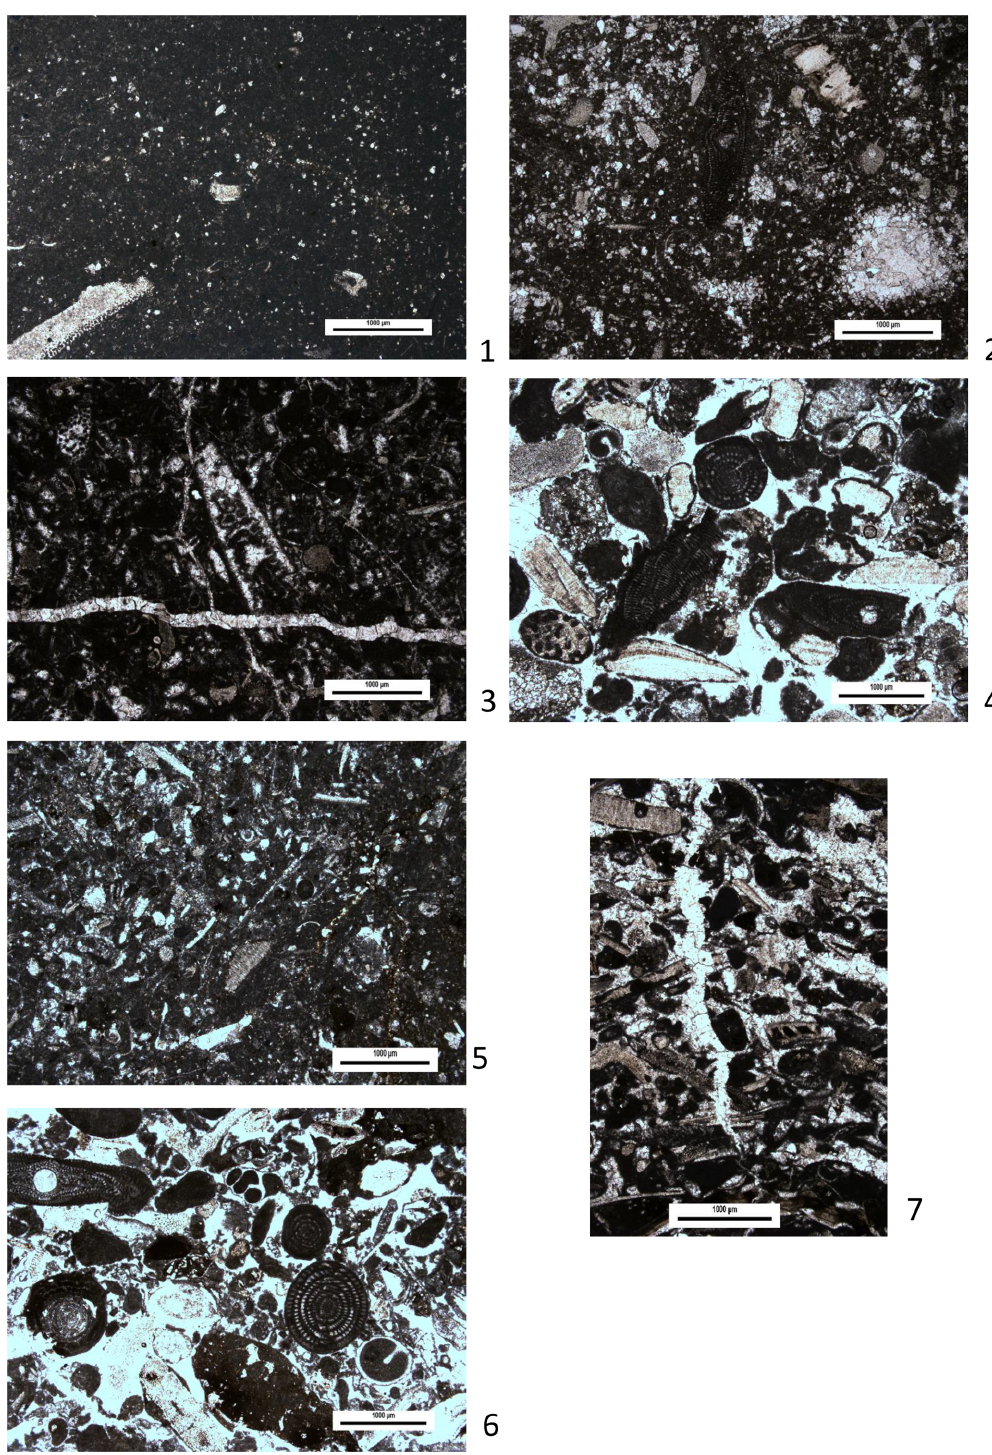
Figure 5. Derdere Formation microfacies: (1) DRK1 – bioclastic mudstone/wackestone with echinoderm debris and planktonic foraminifera; (2) DRK7 – bioclastic wackestone with mollusc and echinoderm debris and rare alveolinid foraminifera; (3) DRK8 – bioclastic wackestone with dasycladalean and udotacean algae and echionderm debris; (4) DRK9 – Bioclastic grainstone with alveolinid foraminifera, mollusc, and echinoderm debris; (5) DRK16 – bioclastic wackestone with echinoderm and mollusc debris and rare discorbid foraminifera; (6) DRK22 – bioclastic–peloidal-lithoclast grainstone with common mollusc and echinoderm debris and alveolinid foraminifera; (7) DRK19 – peloidal– bioclastic packstone with mollusc debris and possible rootlet and microkarst. The scale bar is